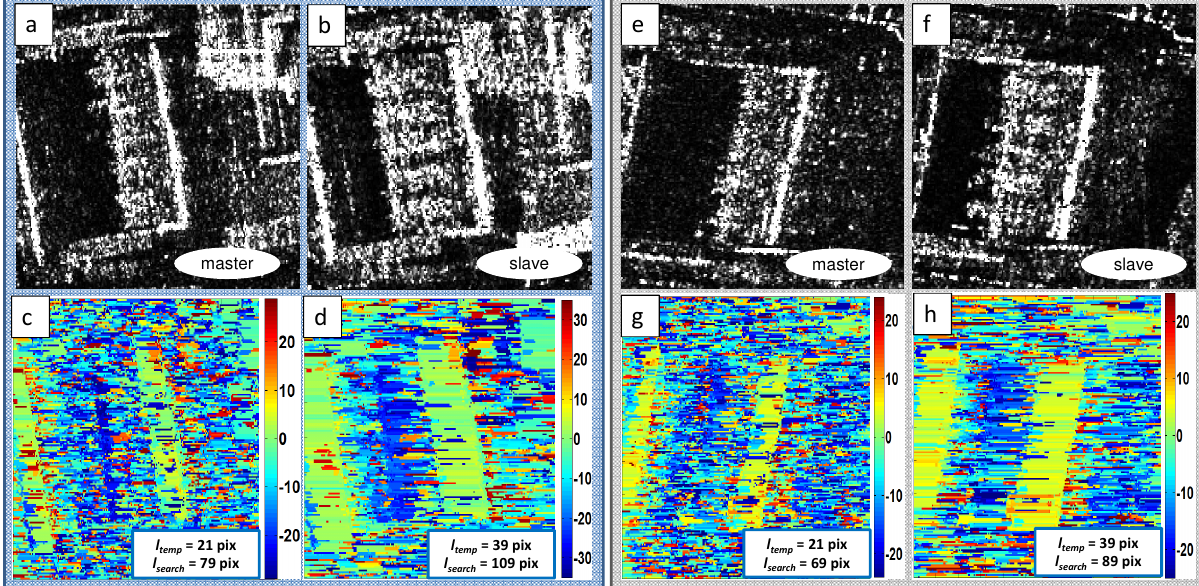
Figure 4: Result of disparity map calculation for same-side ascending (blue) and descending (grey) configurations; a) master image 47°; b) slave image 36°; c) & d) corresponding disparity map for two different indicated l temp and l search ; e) master image 52°; f) slave image 42°; g) & h) corresponding disparity map for two different indicated l temp and l search